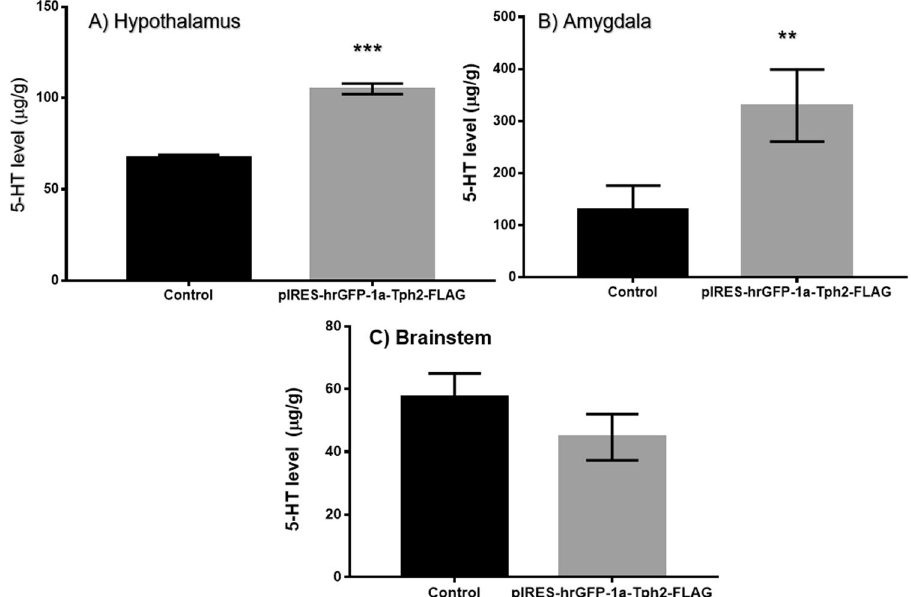
Fig. 3 5-HT level in the hypothalamus, amygdala and brainstem of mice following the ocular treatment with pIRES-hrGFP-1a-Tph2-FLAG. Mice treated with the plasmid pIRES-hrGFP-1a-Tph2-FLAG (25 μ g) via the ocular route showed signi fi cantly higher 5-HT levels than non- transfected control animals both in the amygdala and hypothalamus ( A , B ). No changes were observed in the brainstem ( C ). Data are expressed as the mean ± SEM. ** P < 0.01, *** P < 0.0001 according to the Student ’ s t